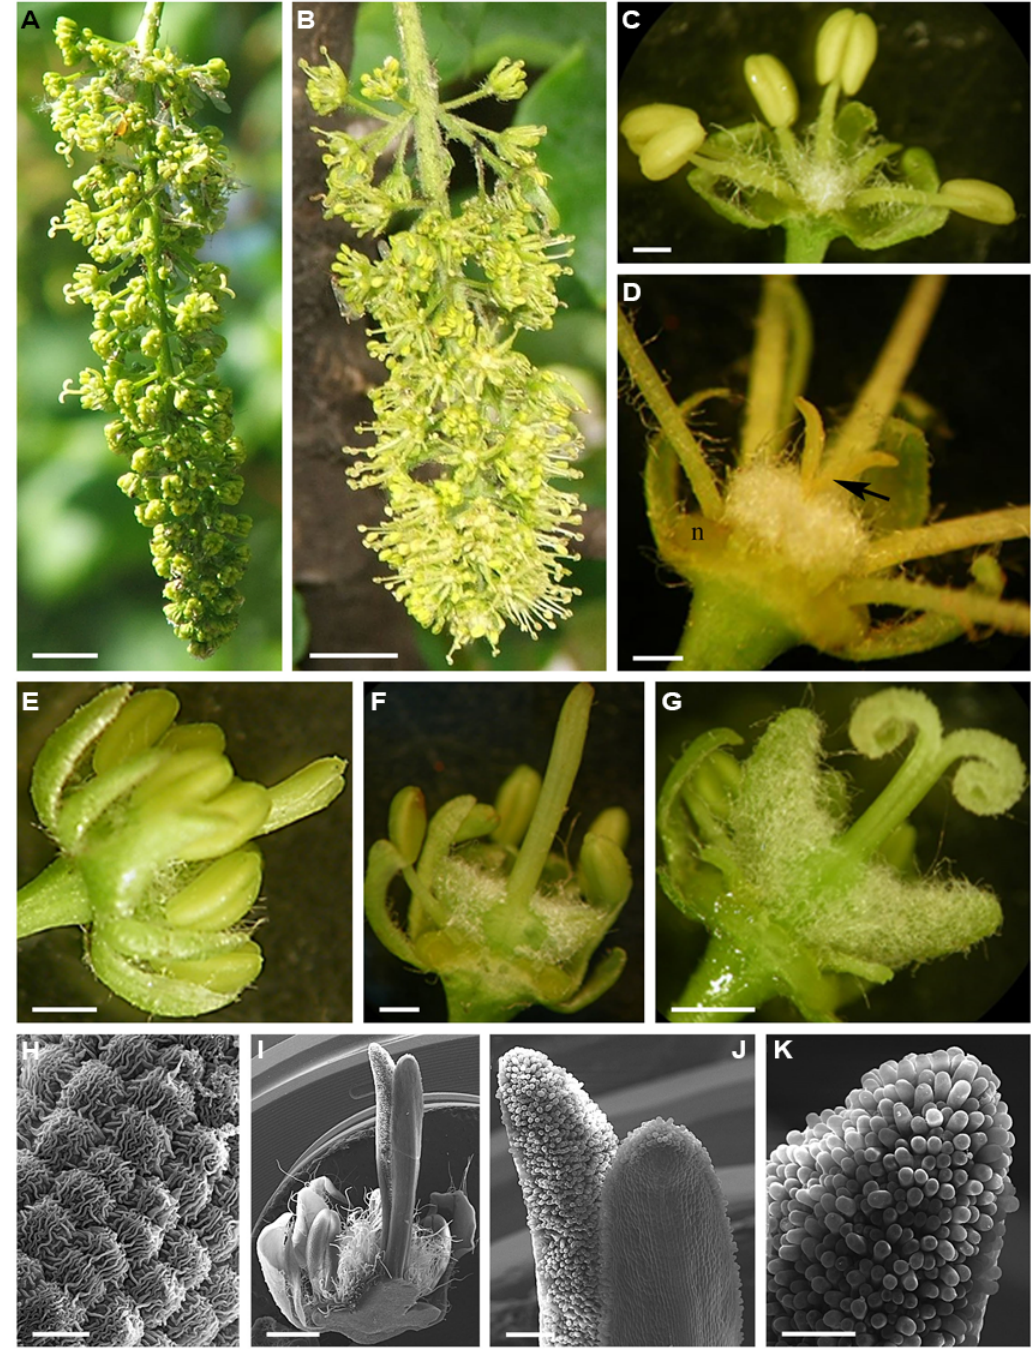
Fig. 1 Acer pseudoplatanus inflorescences, flowers, and floral elements. ( A ) Young inflorescence with visible functionally female flowers; bar = 2 cm. ( B ) Inflorescence with visible functionally male flowers; bar = 2 cm. ( C,D ) Functionally male flowers; bar = 2 mm: absence of a pistil ( C ), reduced pistil, absence of a style, sessile stigma (arrow) ( D ). ( E–G ) Functionally female flowers in various stages of development; bar 2 mm. ( H ) Fragment of epidermis in corolla petals, striae on the epidermis; bar = 20 μm. ( I–K ) Stigma in functionally female flowers;